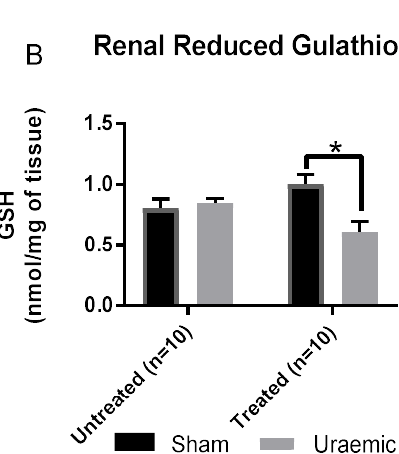
Figure 7. Endogenous antioxidant glutathione level in kidney tissue. ( A ) Renal oxidised glutathione in sham ( n = 10) and uraemic animals ( n = 10) with and without i.v. iron therapy; ( B ) renal reduced glutathione in sham ( n = 10) and uraemic animals ( n = 10) with and without i.v. iron therapy. Results are presented as mean ± SEM. (* p < 0.05).